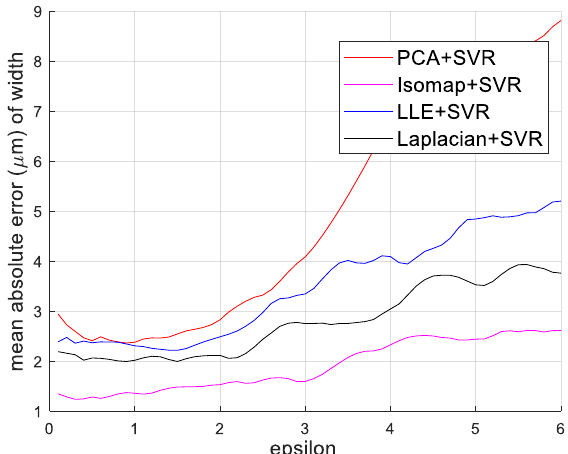
Figure 11. MAE of defect depth estimation for the first 20 dimensional features under different epsilon values.